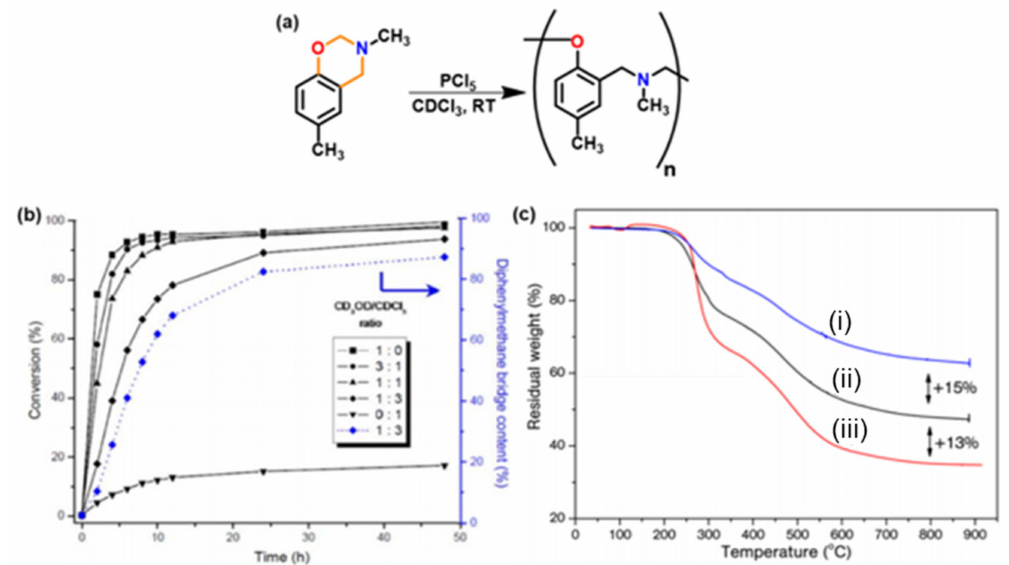
Figure 48. ( a ) Postulated structure of PCl 5 -initiated formation of poly( p C-ma) [255]. ( b ) Monomer conversion vs time for the BF 3 .OEt 2 initiated polymerization of PH-a in CD 3 OD/CDCl 3 mixtures. Percentage of diphenylmethane bridges vs time in a CD 3 OD/CDCl 3 (1/3) mixture is also represented. Polymerization conditions: PH-a = 95 mg, solvent = 0.6 mL, [PH-a] 0 = 0.75 mol/L, [PH-a] 0 /[initiator] 0 = 40/1, and temperature = 60 ◦ C [314]. Copyright 2013. Reproduced with permission from John Wiley & Sons, Inc. ( c ) TGA traces of poly(PH-ba): (i) neat, (ii) in presence of B(C 6 F 5 ) 3 (ii) 3% and (iii) 5% [315]. Copyright 2018. Reproduced with permission from